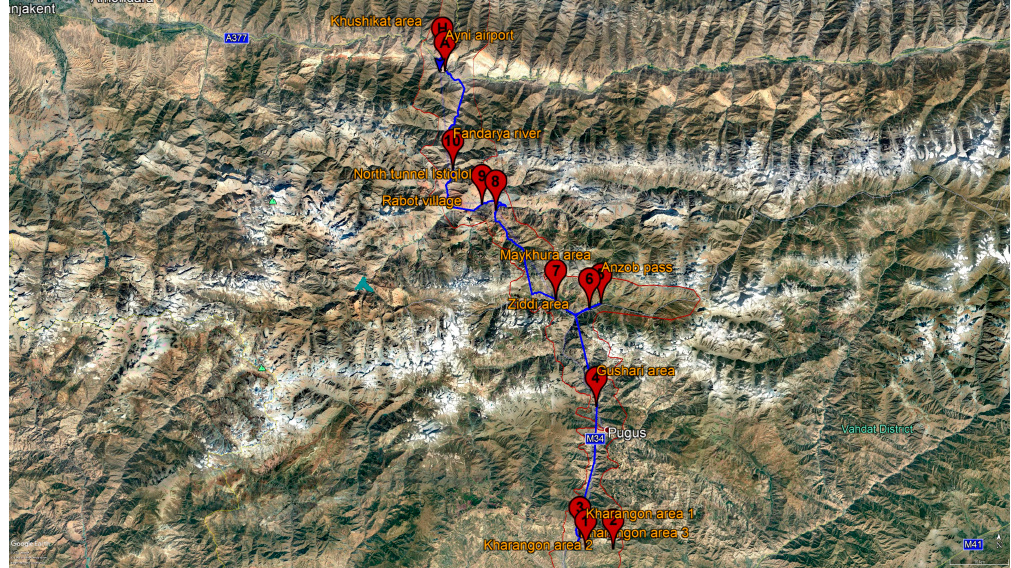
Figure 5. Itinerary of the field survey. The blue line shows a passed route on the M-34 highway; the red points show essential sites chosen for investigation.